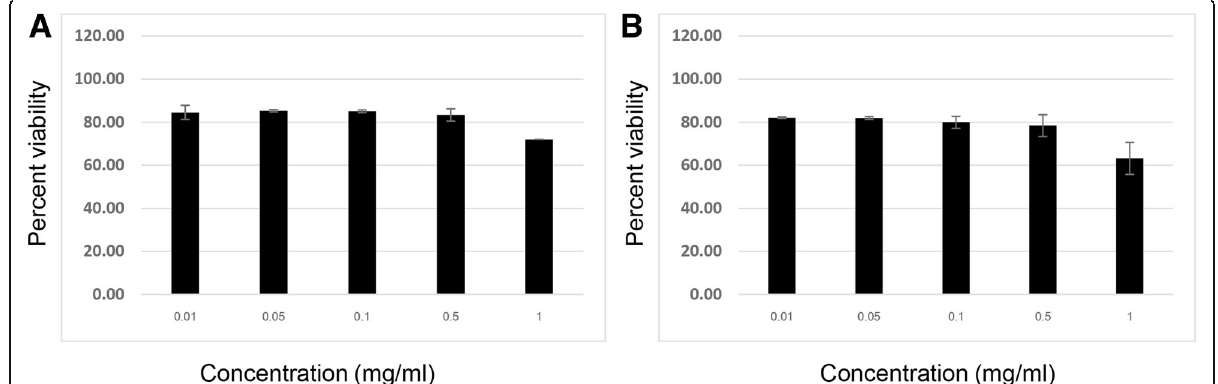
Fig. 3 Effect of NBEF ( a ) and NBWF ( b ) on the viability of HepG2 cells assessed by the MTT assay: Cells were treated with standard concentrations (0.01, 0.05, 0.1, 0.5 and 1 mg/ml) of NBEF and NBWF for 24 h. The results are expressed as the mean ± SD from three independent experiments. DMSO (0.5%) was used as the negative control